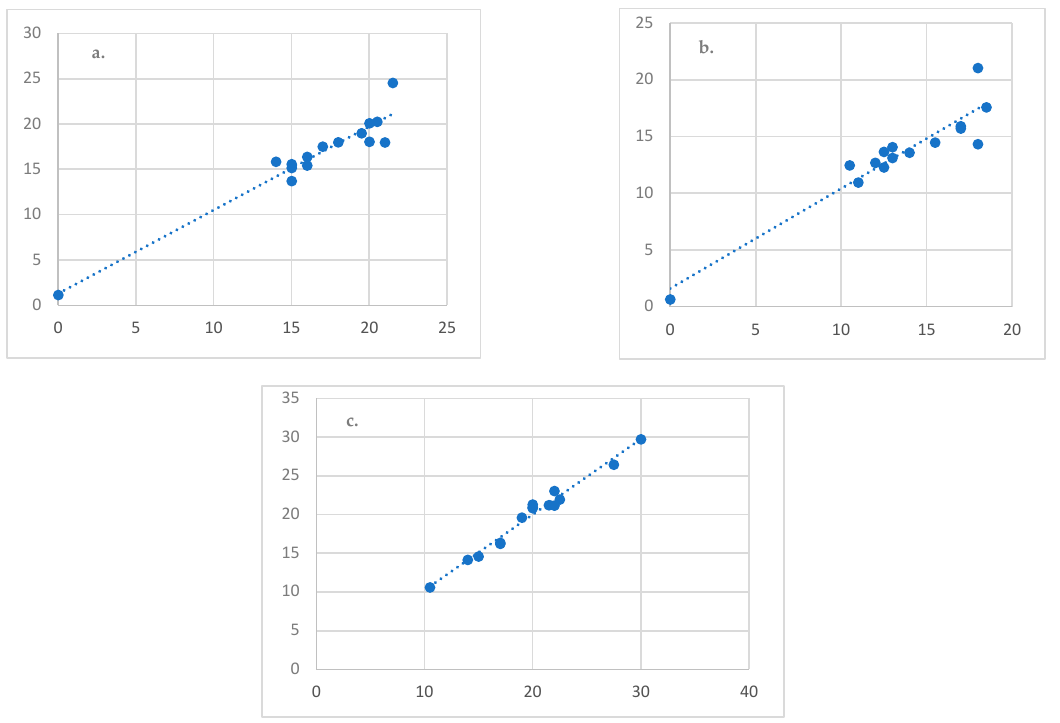
Figure 4. Scatter plot of observed (on x -axis) and predicted (on y -axis) minimum inhibitory concen- trations (MIC) (mg/L) for ( a ) S. aureus ; ( b ) E. coli , and ( c ) C. albicans . PCA showed that the presence of an N atom can explain 42% of the phenomena. The degrees of freedom also have a crucial role in bioactivity. Pose energy and torsion energy count for the rest of the phenomena.